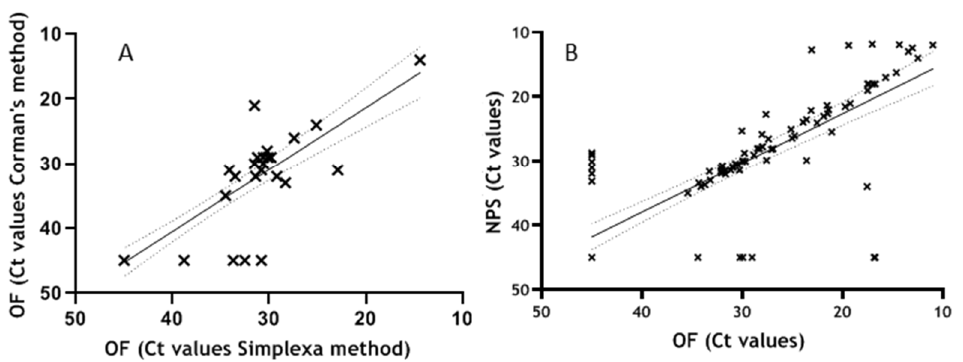
Figure 2. ( A ) Correlation between Simplexa ™ COVID-19 Direct assay and reference method applied to OF samples. Ct values obtained on 41 OF samples tested in parallel with Simplexa ™ COVID-19 Direct assay and RT-PCR by Corman VM reference method are included in the linear regression analysis (r = 0.770; p < 0.0001). ( B ) Correlation between NPS and OF samples. Results obtained from 292 samples tested for the presence of SARS-CoV-2 RNA both in NPS and OF matrices are included in linear regression adjusted for cluster, sex and age ( r = 0.921; p < 0.0001).